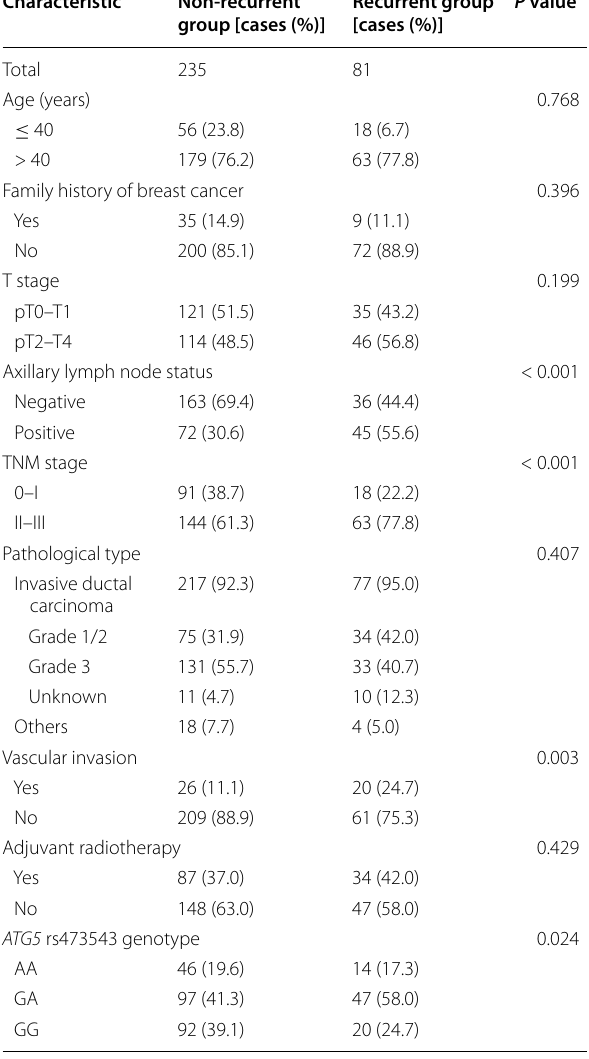
Table 2 Different clinicopathological characteristics in the recurrent group and the non-recurrent group of TNBC patients